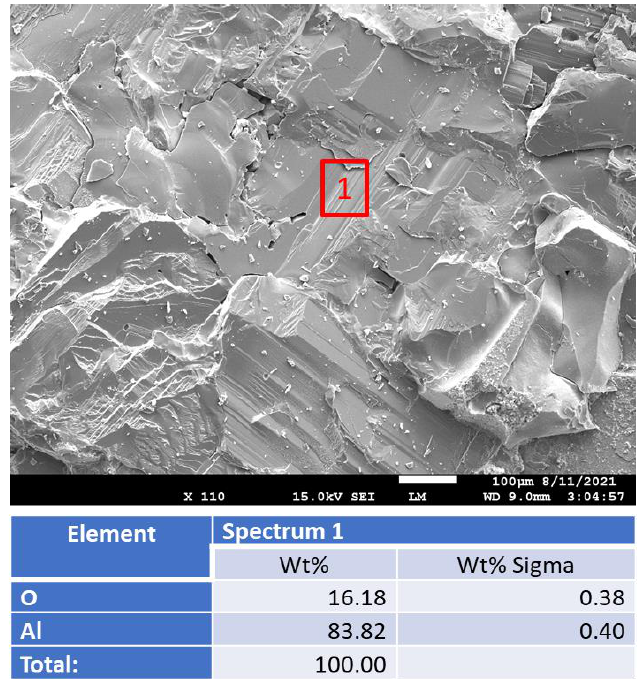
Figure 31. Photomicrograph of an aluminum-oxide sample with the elemental composition of a typical site shown by the red box after alkaline carbonation at 250 °C for 40 days.